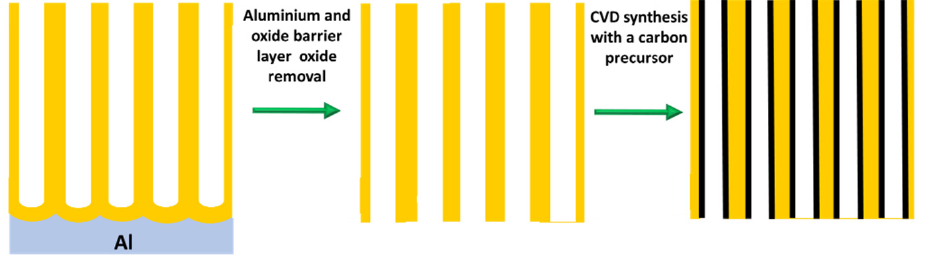
Figure 10. Methodology for the catalyst-free synthesis of CNTs within PAA templates. The black lines represent the CNTs growth on the PAA walls.